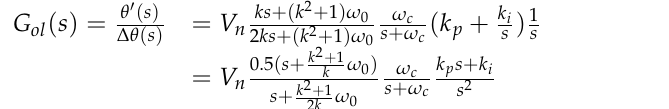
Analyzing Figure 8, the open-loop transfer function of CCF-MFOF-PLL can be ob-